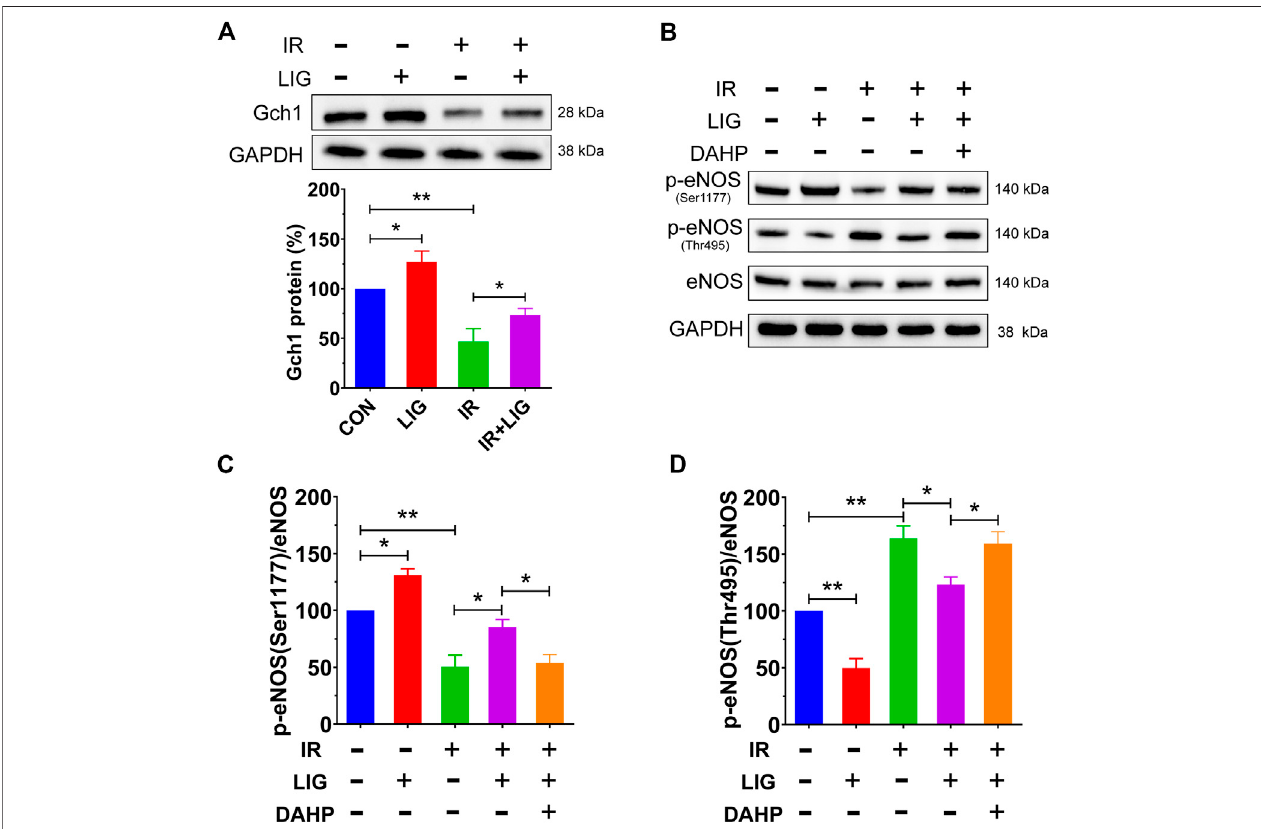
FIGURE 5 | Effects of LIG on the Gch1 protein and phosphorylated eNOS levels in IR-exposed HUVECs. HUVECs were pretreated with LIG (1.0 μ M), DAHP (10 mM)or L -NAME(100 μ M)for12h,followedby10 Gyofirradiation. (A) Representativeimmunoblotsandquanti fi cationofbanddensitiesshowingGch1withGAPDH as a loading control after IR of HUVECs. (B – D) The levels of p -eNOS (Ser1177), p-eNOS (Thr495), and total eNOS protein were measured by western blotting. Representative images of experiments and densitometric analysis of the phosphorylated proteins normalized to the total protein level. Data are the mean ± SEM, n (cid:1) 4. * p < 0.05; ** p <